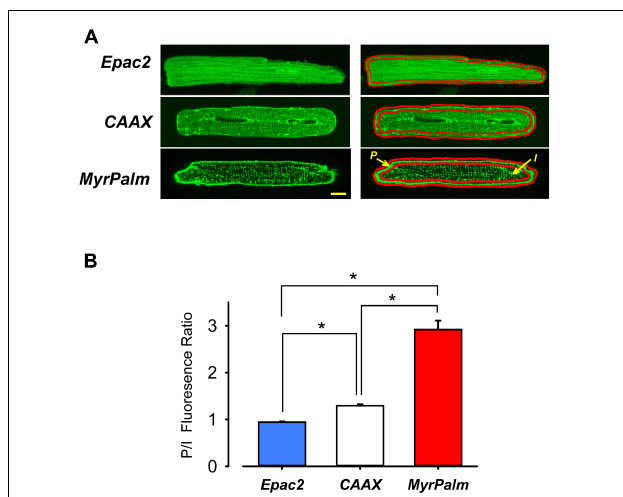
FIGURE 1 | Targeting of Epac2-based FRET biosensors to different subcellular locations in adult ventricular myocytes. (A) Confocal images of adult rat ventricular myocytes expressing Epac2-camps (Epac2), Epac2-CAAX (CAAX), and Epac2-MyrPalm (MyrPalm). Average fluorescence intensity was measured at the periphery (P) and in the interior (I) of cells (as illustrated in the right hand panels) to obtain P/I fluorescence intensity ratio as shown. Scale bar: 10 µ m. (B) Summary of average P/I ratio in cells expressing Epac2 (blue bar), CAAX (white bar), and MyrPalm (red bar). The significant difference ( ∗ p < 0.001, n/N = 21/7, Epac2; 22/8, CAAX; 10/4, MyrPalm; Kruskal–Wallis one-way ANOVA on Ranks followed by Dunn’s test for pairwise multiple comparisons) in the P/I fluorescence intensity ratios for the different biosensors demonstrate that Epac2-MyrPalm expression is more prominent in the peripheral plasma membrane, while Epac2-CAAX is more uniformly expressed in the plasma membrane throughout the cell, including the